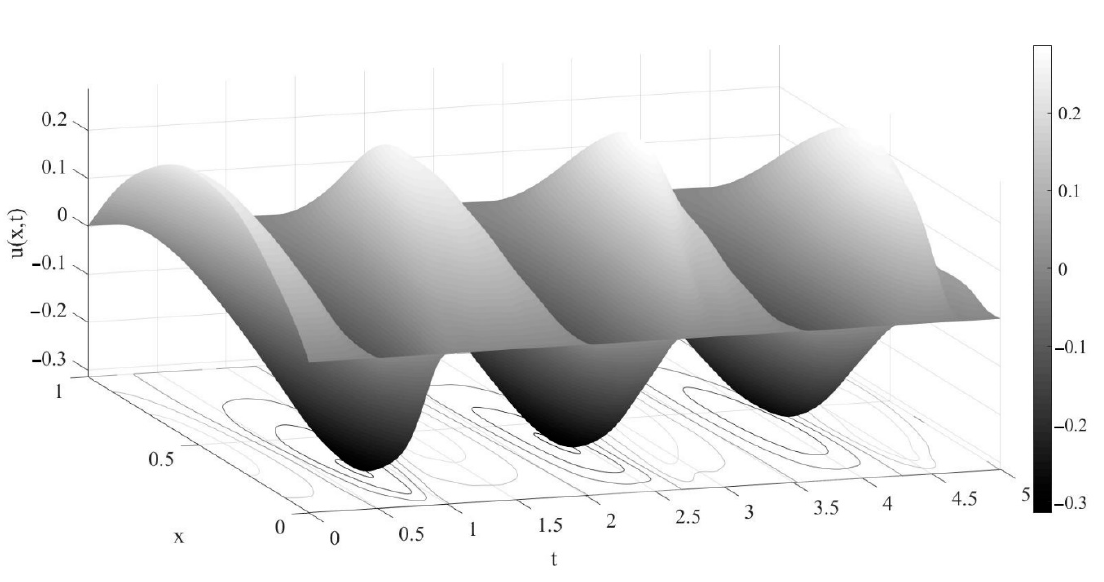
Figure 4. A graph of the approximate solution u ( 7 ) ( x , t ) of problems (1)–(4) under the imposed conditions in Example 3.